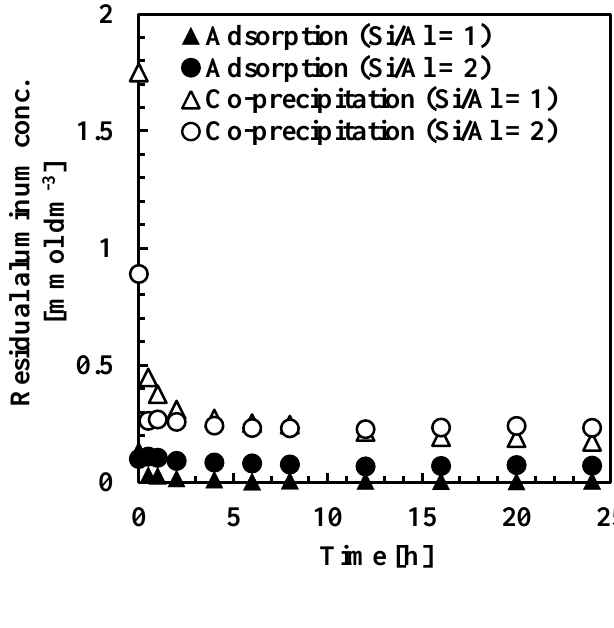
Figure 8. Residual aluminum concentration in co-precipitation and adsorption